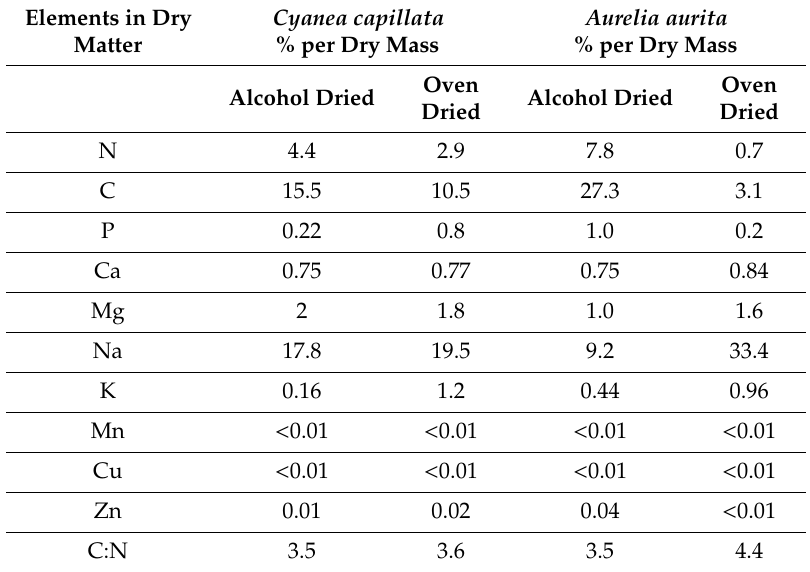
Table 1. Some macro- and microelement compounds of jellyfishes ( Aurelia aurita and Cyanea capillata ). Cyanea capillata Aurelia aurita Elements in Dry Matter % per Dry Mass % per Dry Mass Oven Oven Alcohol Dried Alcohol Dried Dried